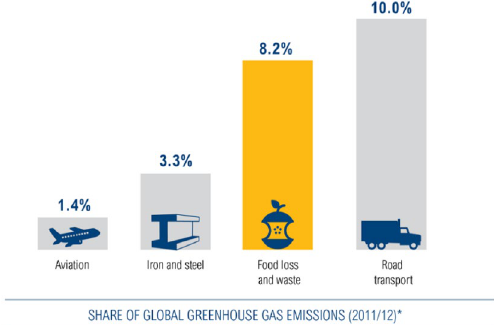
Fig. 8 Green house emission (FAO 2015)